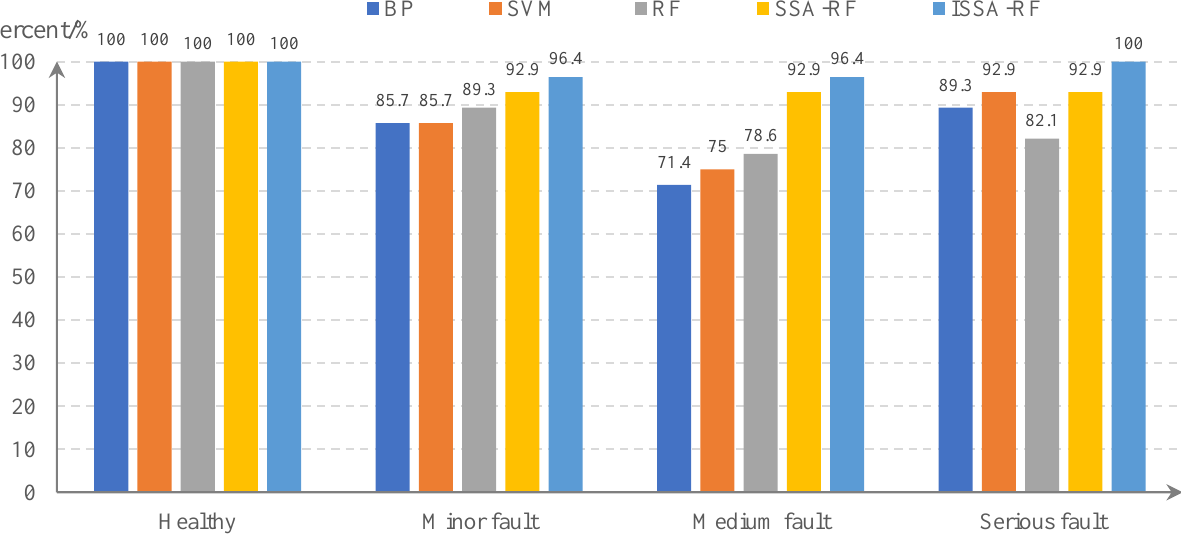
Figure 11. Specific accuracy of different fault degrees (unit: %).